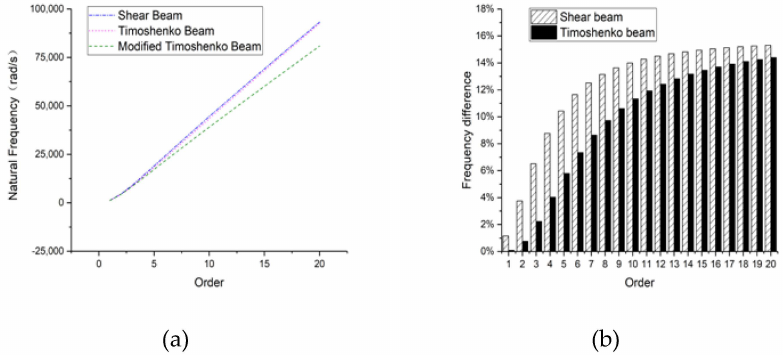
Figure 24. Natural frequencies of the 2-m-long beam: ( a ) overall frequency curve and ( b ) frequency di ff erence compared with a modified Timoshenko